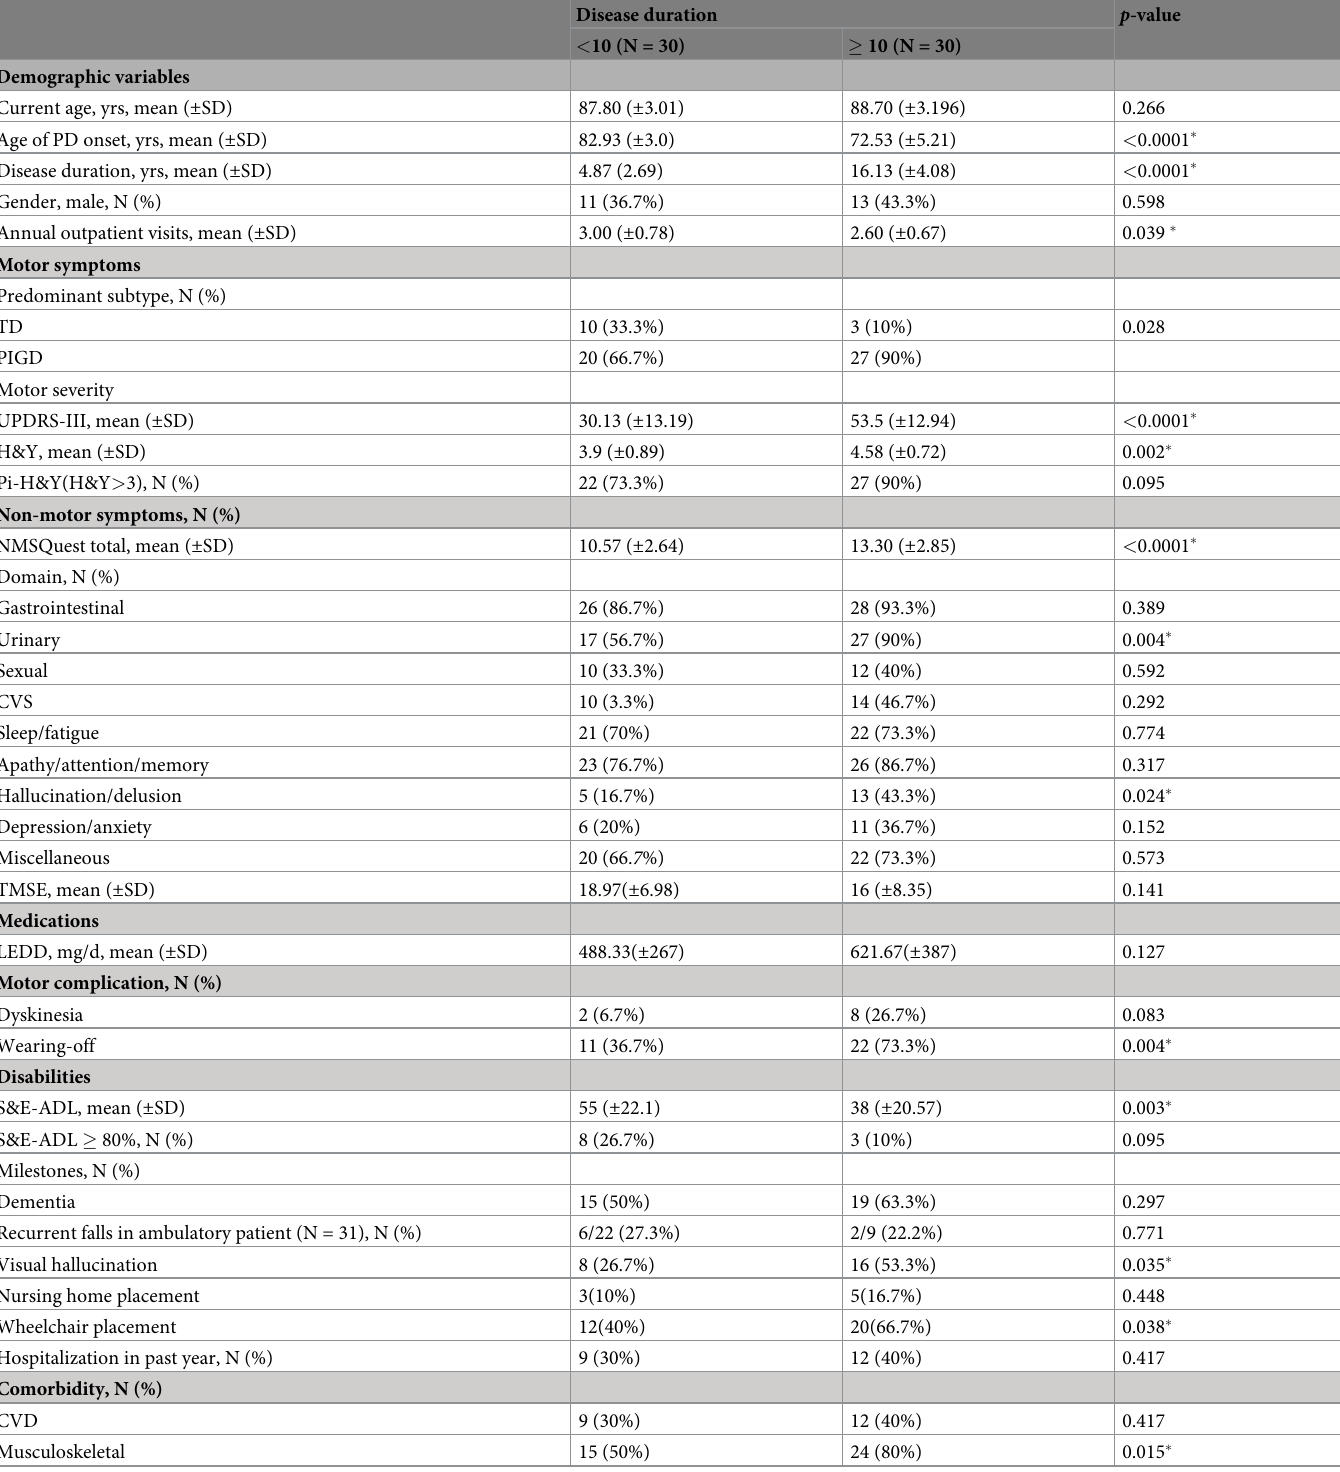
Table 2. Comparison of demographic and clinical characteristics for old-old PD patients with disease duration < 10 years versus those with disease duration � 10